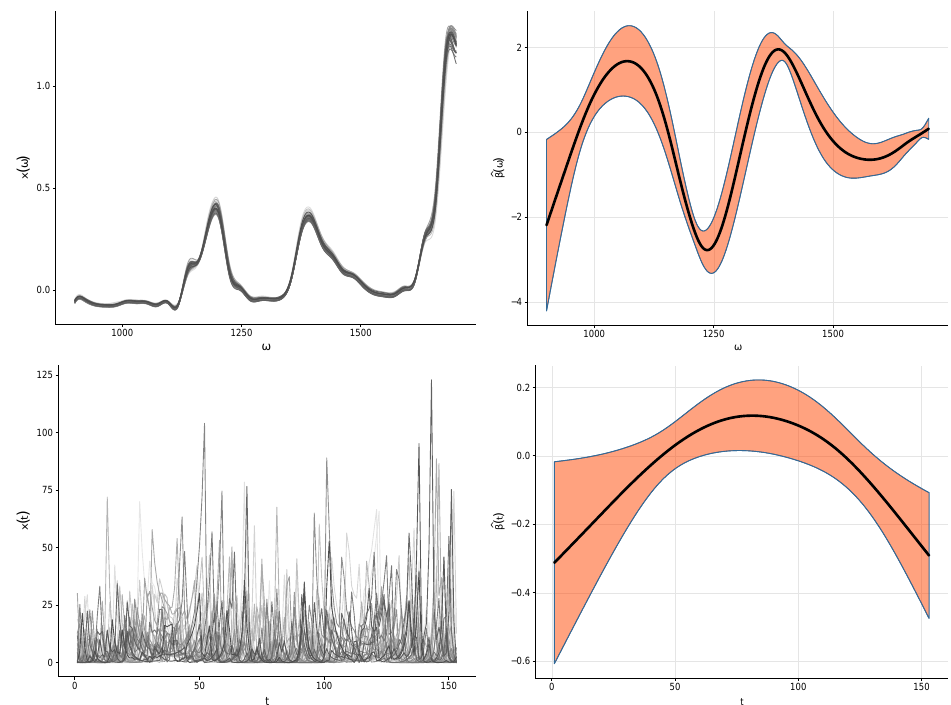
Figure 4. (top left) The reflectance spectra curves; (top right) the parameter curve estimate displaying the association between the octane rating and the near-infrared reflectance spectra curves is shown in the, together with a 95% point-wise confidence interval; and (bottom) analogous graphs for the streamflow and precipitation